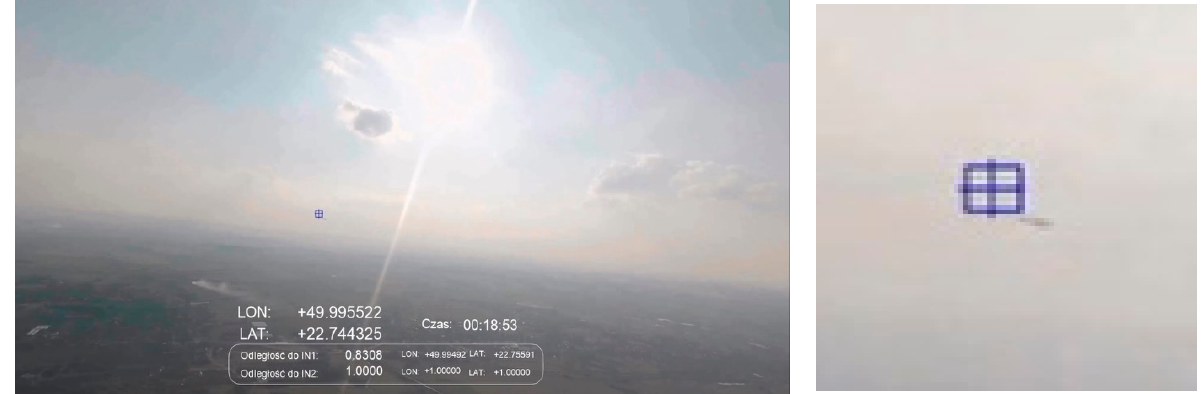
Figure 11. Scenario related to Figure 5B; late afternoon, altitude ~500 m, distance to intruder: 830 m.